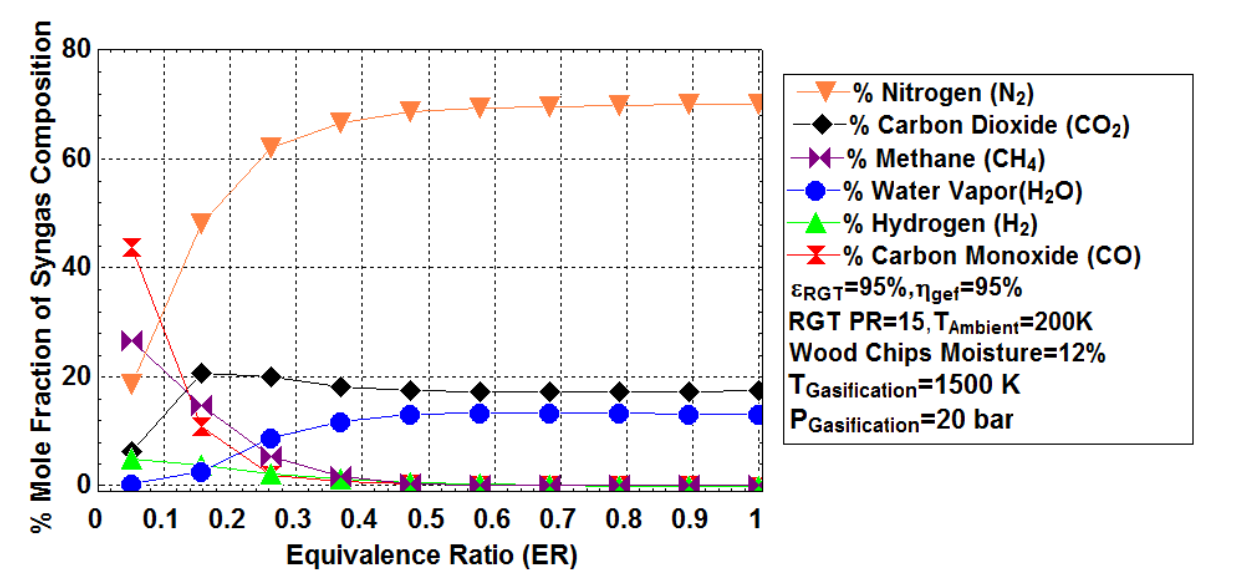
Figure 6. Influence of rquivalence ratio on the composition of the syngas.